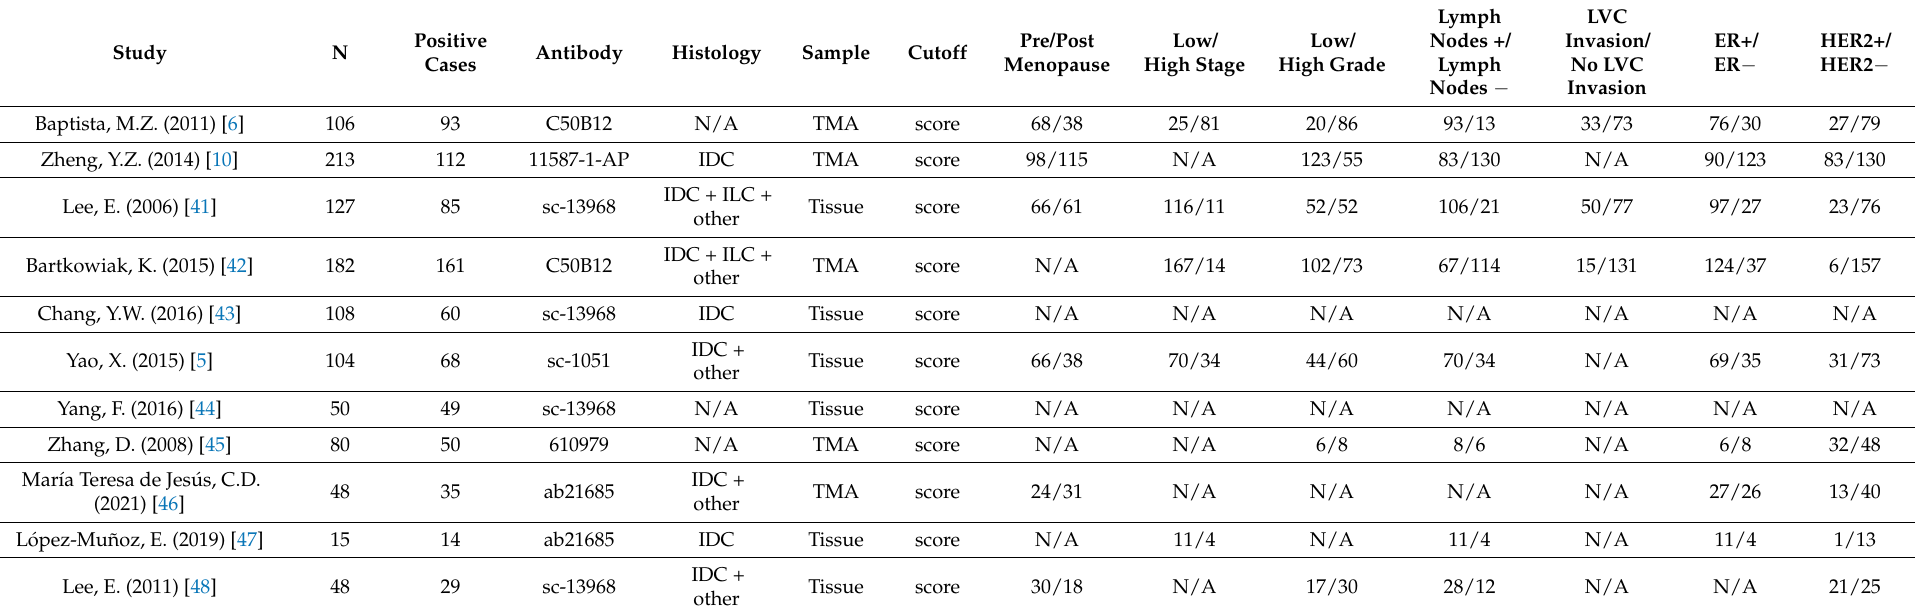
Table 4. Characteristics of the studies included for meta-analysis of GRP78/BiP in breast cancer.